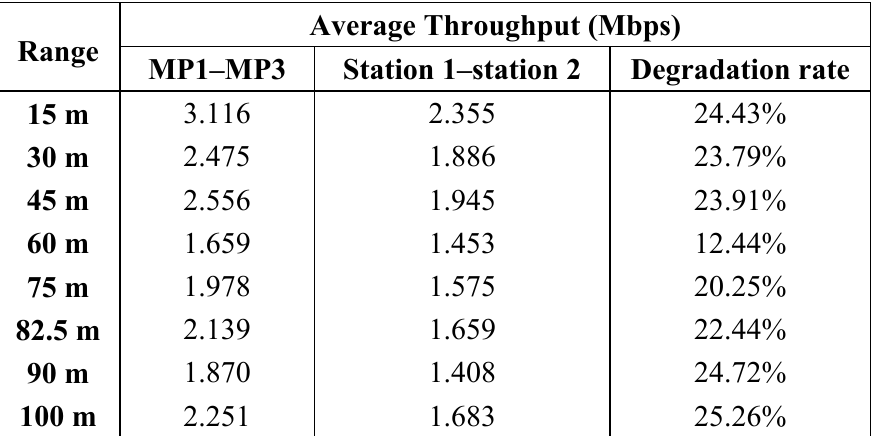
Table 4. A comparison between test 1 and test 3.